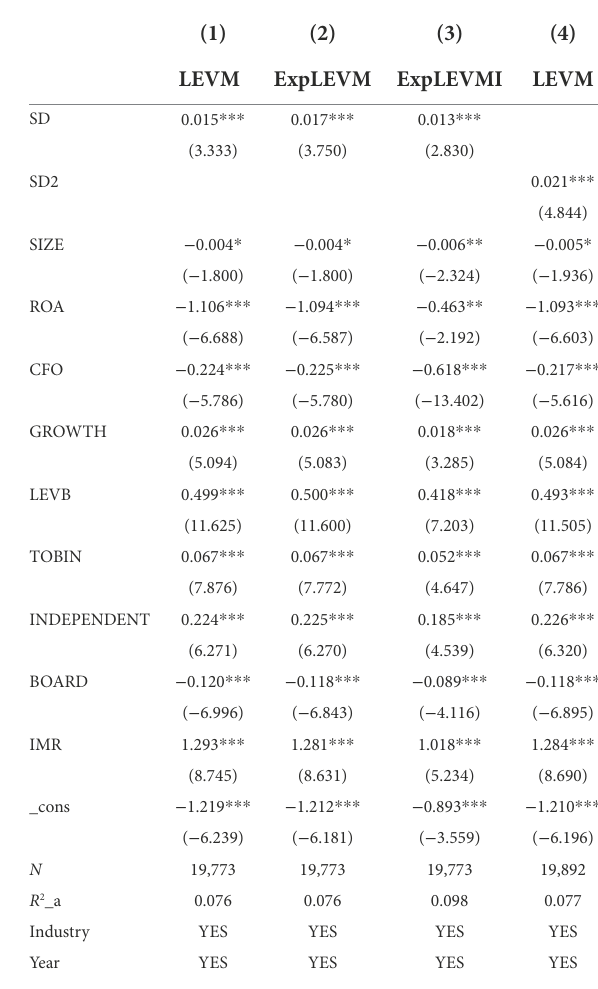
TABLE 12 Control possible missing variables. TABLE 13 Heckman two-step